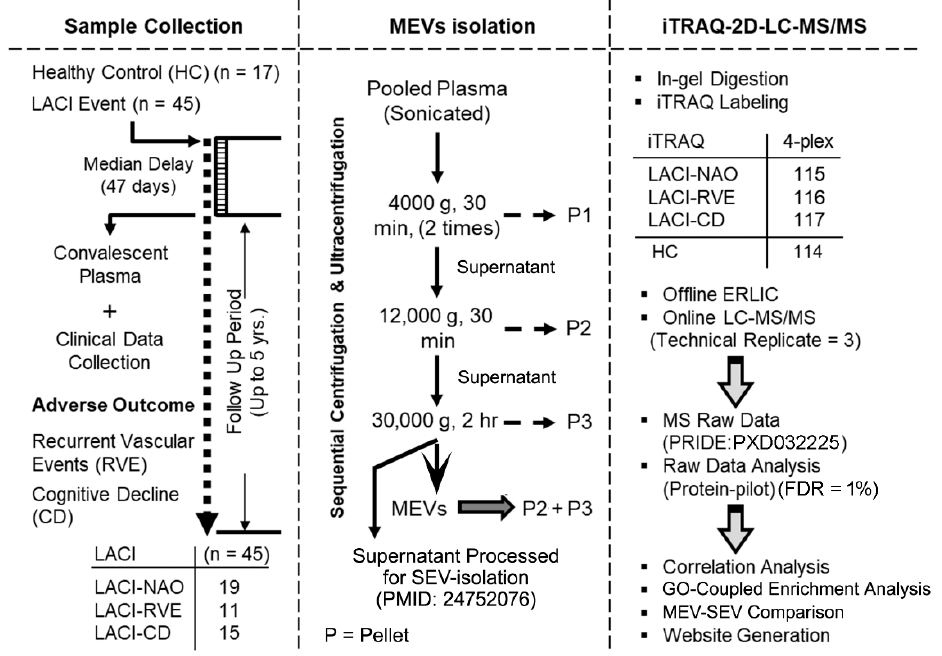
Figure 1. Schematic presentation of the experimental design. The LACI patients are grouped based on adverse outcome (RVE or CD) or no adverse outcome (NAO) when followed up for up to 5